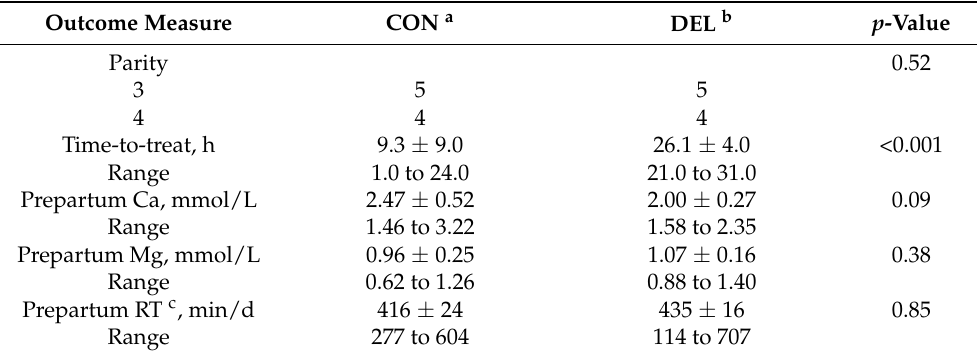
Table 2. Descriptive statistics of the study population for parity, time between calving and calcium bolus administration (Time-to-treat), measures of prepartum blood calcium (Ca) and magnesium (Mg), taken 1 week prior to expected calving date, and total daily rumination time (RT). Parity is presented as the number of cows/group/parity and all other outcomes are presented as the mean ± SD and range per treatment group.